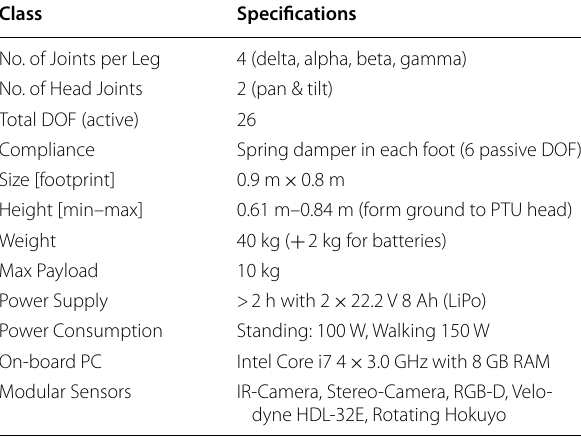
Table 3 The technical specifications of Lauron-V [30, 31]